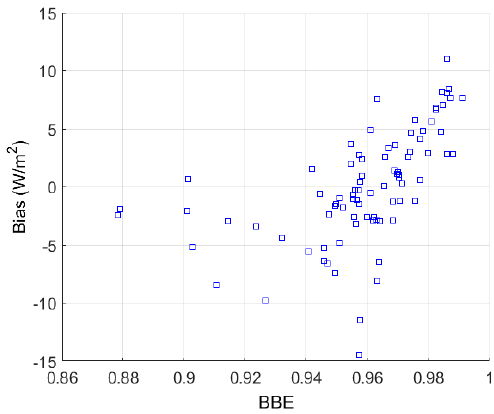
Figure 8. The relationships between Broadband Emissivity (BBE) versus bias of retrieved LWUP.